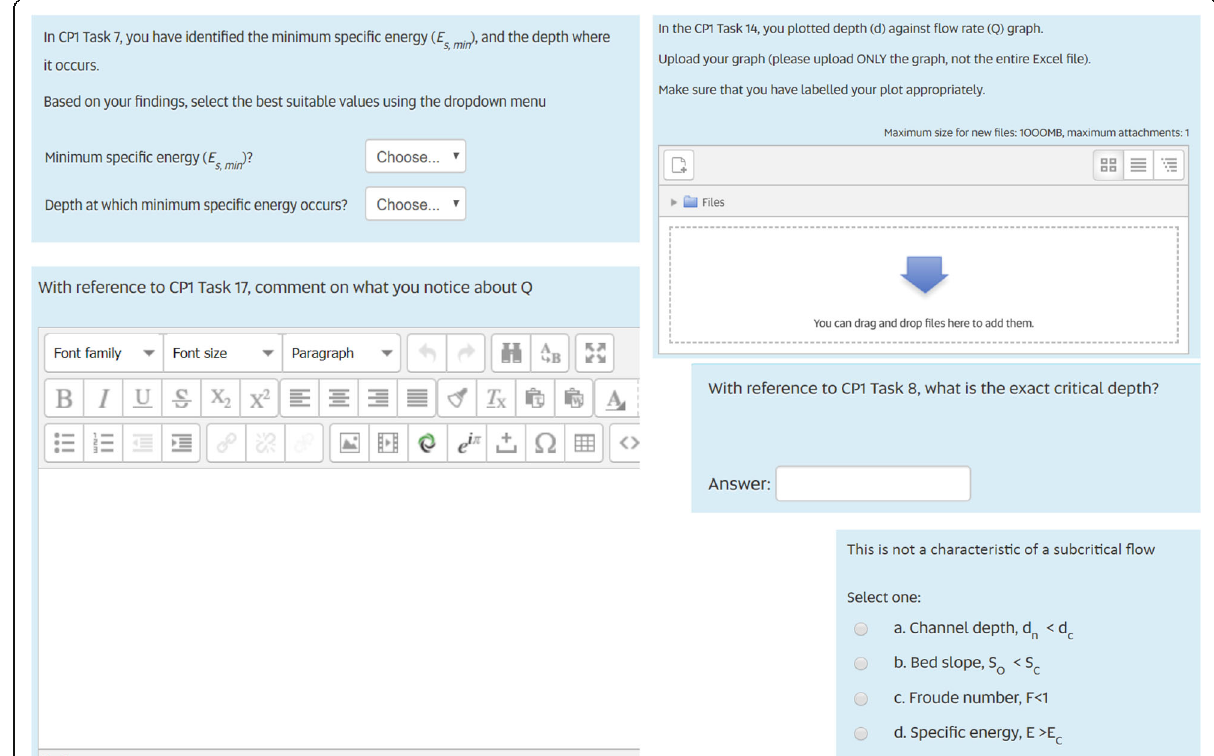
Fig. 6 Examples of question types included in the quizzes